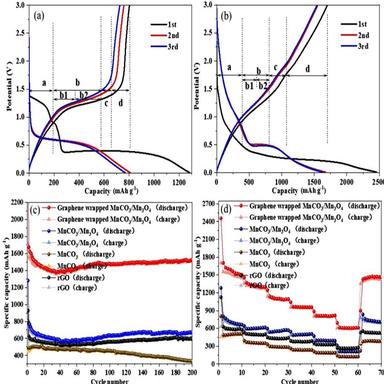
Galvanostatic discharge/charge profiles of (a) MnCO3/Mn3O4 and (b) graphene-wrapped MnCO3/Mn3O4 nanocomposite, (c) Cycling performance, (d) Rate capability.